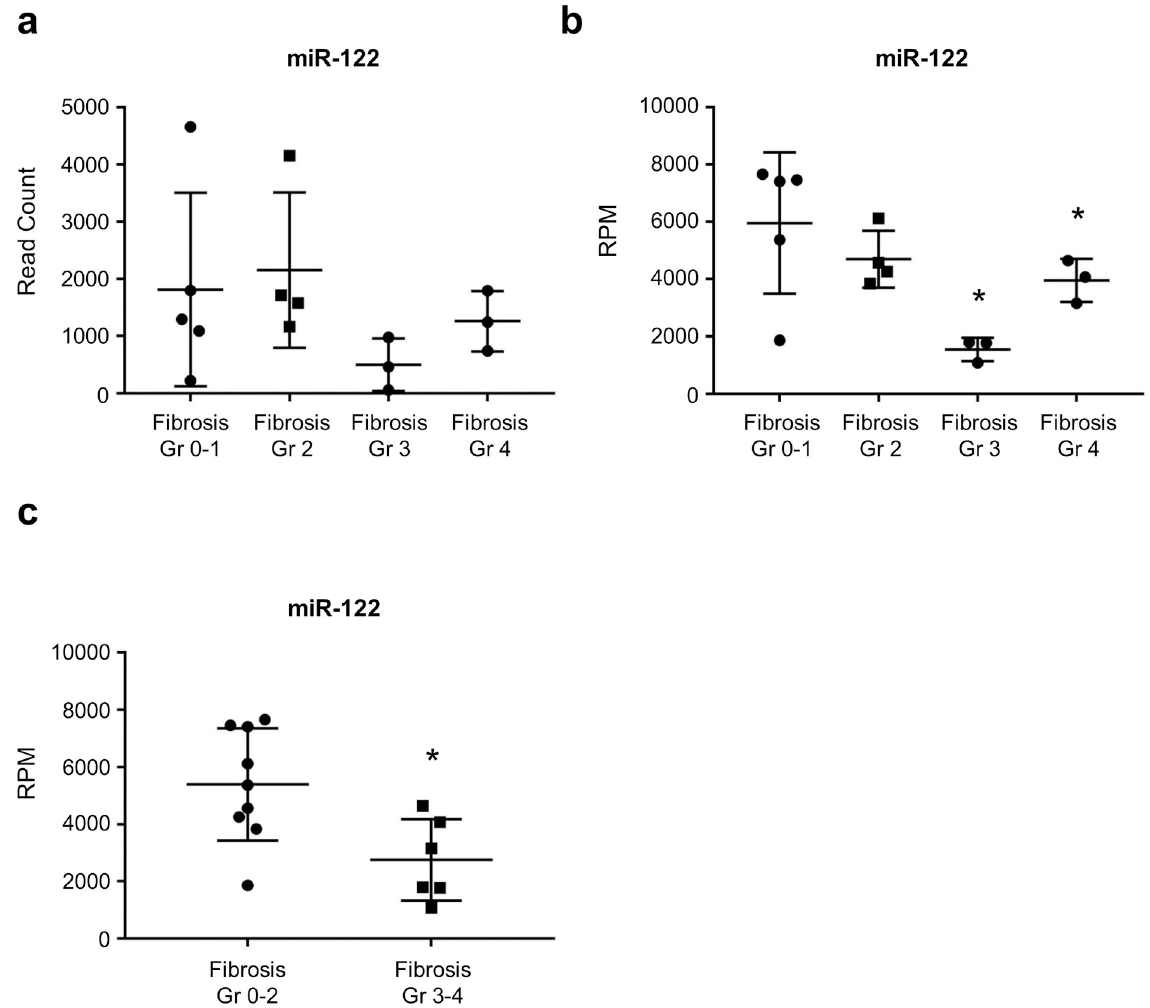
Fig 2. The expression of miR-122 is decreased as liver fibrosis progressed. (a) Read counts and (b) RPM counts by NGS according to liver fibrosis stages. (c) RPM of miR-122 patients divided into fibrosis stage 0–2 and fibrosis stage 3–4. Data were analyzed by omitting outliers. � : p <